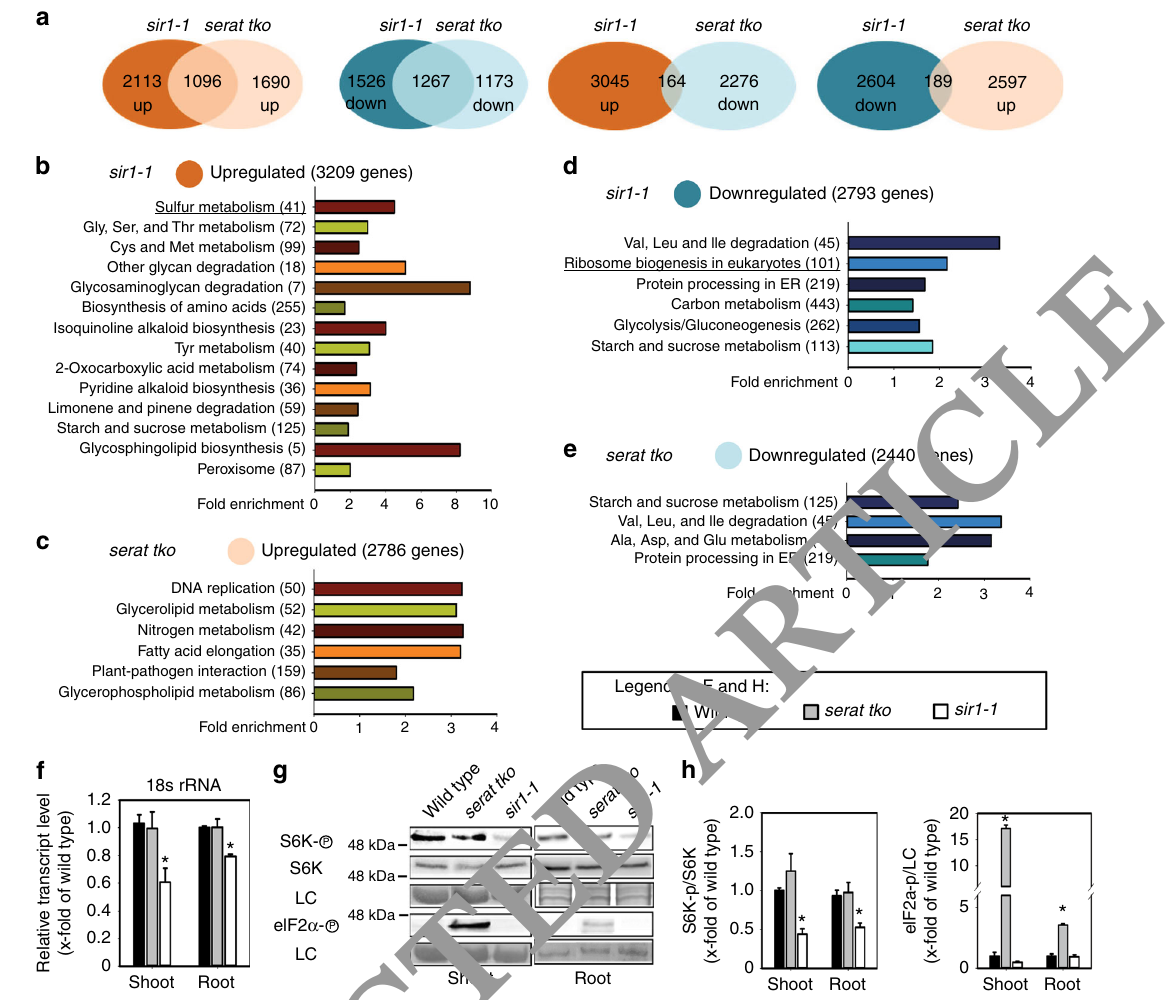
Fig. 2 Speci fi c sensing of C/N- or S-precursors for Cys results in distinct transcriptome reprogramming and speci fi c translation regulation. a Venn diagrams and b – e functional category analysis ( p < 0.05, FDR < 0.25) for transcriptional response in roots of 7-week-old serat tko and sir1-1 plants. The compared sets of genes contained transcripts, which were signi fi cantly ( p < 0.05) up- or downregulated by more than 1.25-fold in sir1-1 or serat tko in comparison to the wild type. The details of the highlighted categories with underlines are further presented in Supplementary Figs. 2 and 4. f Speci fi c downregulation of 18s rRNA in response to sul fi de limitation ( n = 3, mean ± s.e.m., one-way ANOVA, * p < 0.05). g TOR and GCN2 activity was determined by antibodies against S6K-p, S6K (apparent sizes: 52 kDa) and eIF2 α -p (apparent size: 43 kDa) and h calculated by the ratio of S6K-p/S6K and eIF2 α -p/LC in x-fold of wild type ( n = 3, mean ± s.e.m., one-way ANOVA, * p < thereby coordinating the fl ux of sulfur with the fl uxes of carbon and nitrogen 24 . Provision of sul fi de by sul fi te reductase (SiR) and the C/N precursor O -acetylserine (OAS) by serine acetyl- transferase (SERAT) are known to limit cysteine synthesis in – 28 (Fig. 1a). In order to understand sensing of cysteine plants 25 limitation in autotrophic eukaryotes, we used Arabidopsis thali- ana to engineer a triple knockout plant ( serat tko ) that lacked the major SERAT isoforms in the cytosol (SERAT1;1), the plastids (SERAT2;1), and the mitochondria (SERAT2;2) and compared it to the sir1-1 knock-down plant (Fig. 1b and Supplementary Fig. 1a). SERAT activity was unaffected in sir1-1 and decreased to 5 ± 2% (mean ± s.e.m.) of wild-type level in serat tko (Supple- mentary Fig. 1b). The sir1-1 mutation decreased SiR abundance to 8 ± 4% (mean ± s.e.m.) of wild-type level. The SiR abundance was enhanced in serat tko strongly suggesting that sul fi de supply by SiR is not co-downregulated in this mutant (Supplementary Fig. 1c). Both mutants were impaired in cysteine synthesis and retarded in growth compared to wild type (Fig. 1b and Supple- mentary Fig. 1d). Signi fi cantly lowered translation of proteins as